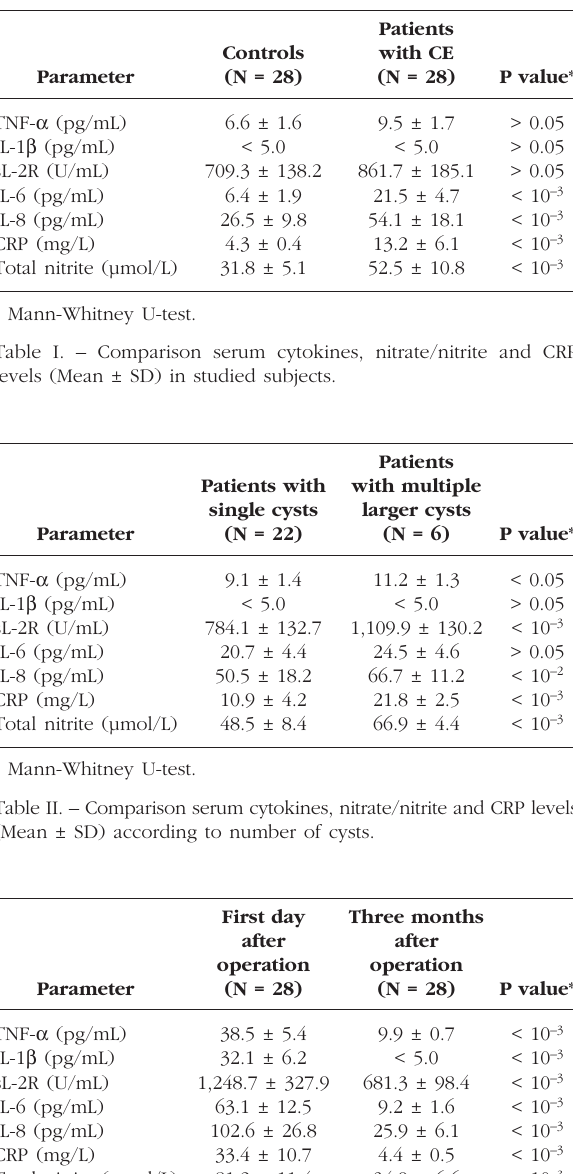
Table III. – Serum cytokines, nitrate/nitrite and CRP levels (Mean ± SD) at different periods after surgical